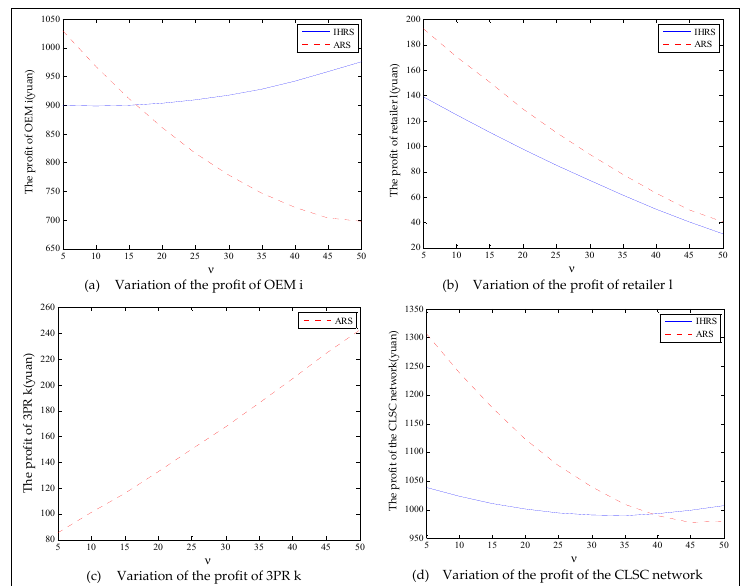
Figure 10. The variation of the profits in Case 2 of Section 6.1.